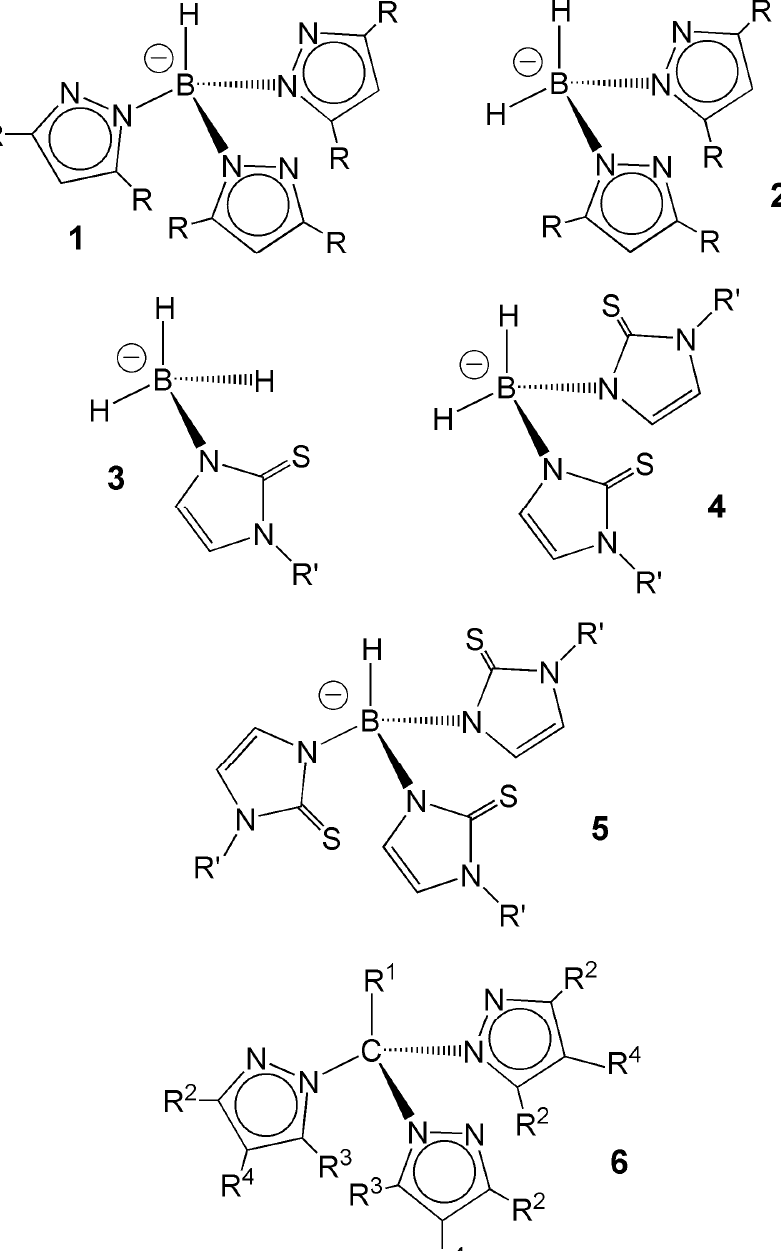
Figure 1. Schematic drawings of the chemical structure of scorpionate ligands. Poly(pyrazolyl)borates, [HB(R 2 pz) 3 ] − ( 1 , 2 ), poly(mercaptoimidazolyl)borates [HB(Rmz) 3 ] − ( 3 ), [HB(Rmz) 2 − ( 4 ), [HB(Rmz)] − ( 5 ), tris(pyrazolyl)methane [HC(R 3 pz) 3 ] ( 6 ), R, R’, R 1,2,3,4 = organic functional groups.